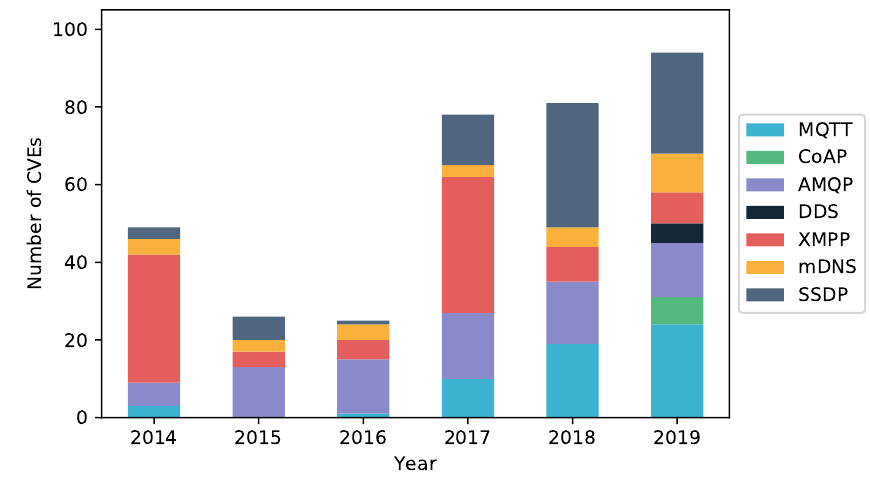
Figure 3. Breakdown of the CVEs per year and